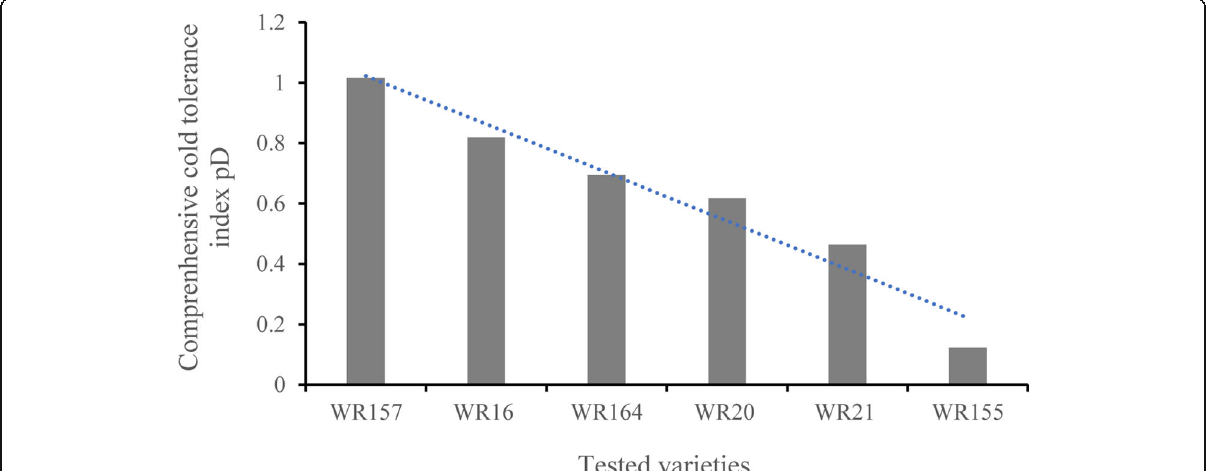
Fig. 1 The changed trend of cold-tolerance capacity of 6 select varieties based on 9 physiological indicators. The p D value based on the 9 physiological indicators, and the meaning is equal to the significance of the D value based on the 5 morphological indices. 9 physiological